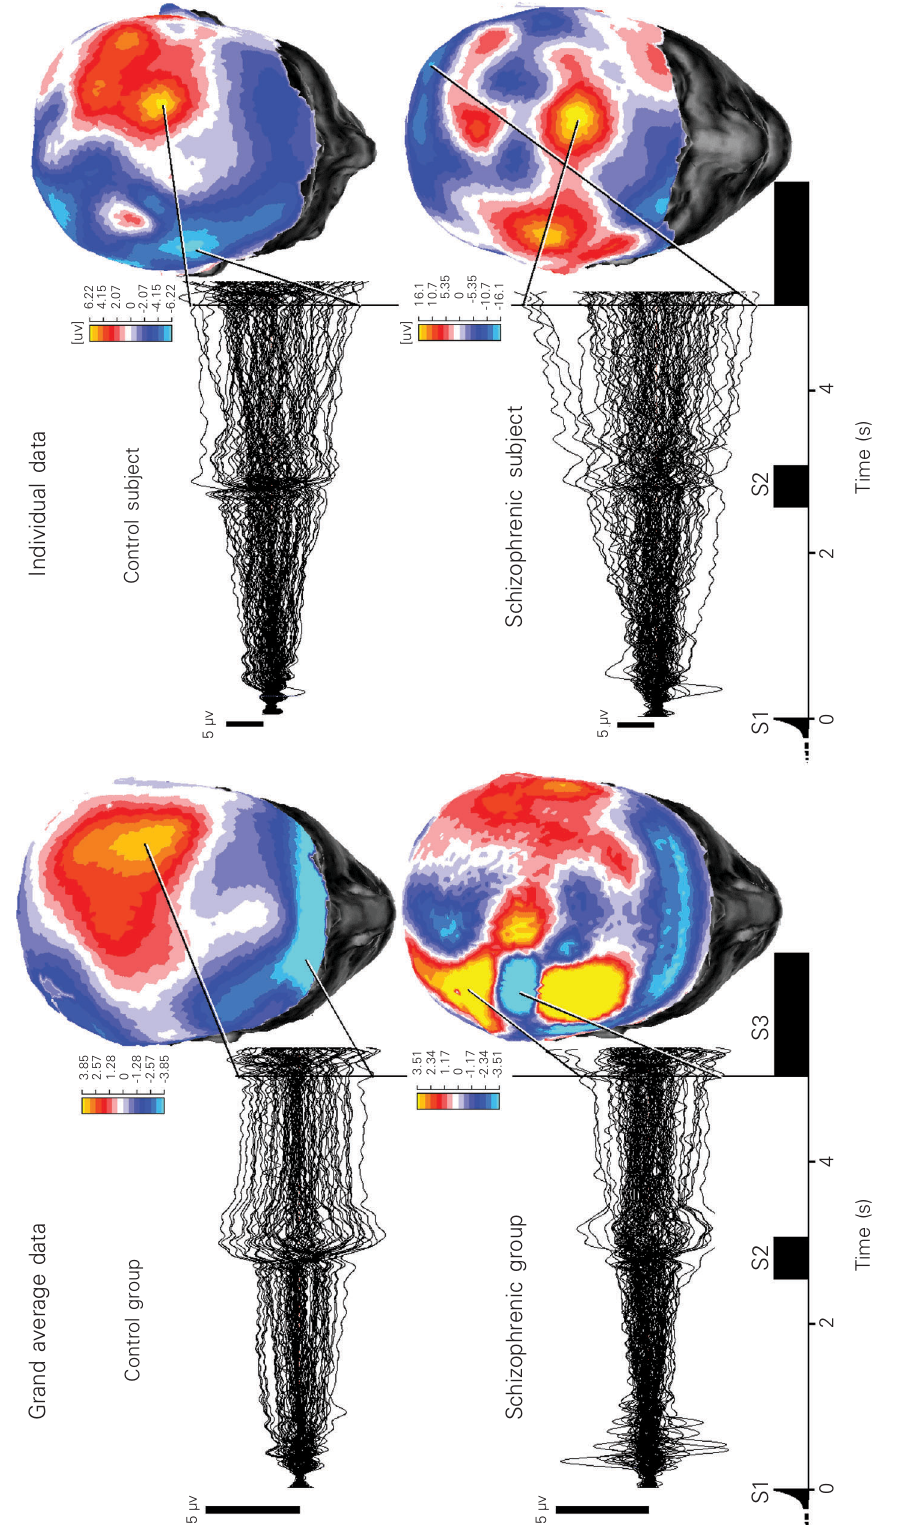
Figure 1. Group averages and individual examples of slow po- tentials and corresponding iso- potential contour maps. Maps shown were at the onset of S3 - performance feedback stimu- lus. Angle of view: 40 º from the nasion-right-left preauricular plane. Maps were projected on the skin surface and were auto- matically segmented from indi- vidual magnetic resonance im- ages. Group average maps were normalized so that each individual contributed equally with respect to electrical power, and were projected onto the segmented skin of a sub- ject with medium head